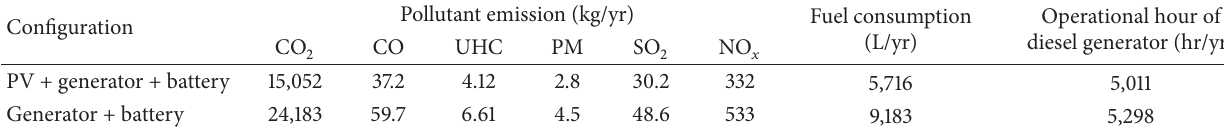
Table 6: Comparative emissions of hybrid power and stand-alone generator supply systems.